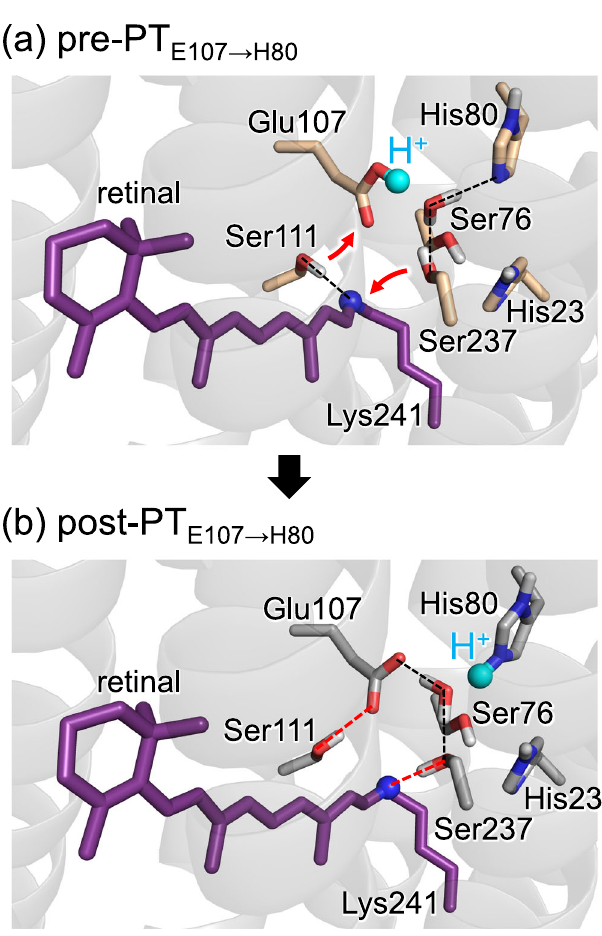
Fig. 4 Reorientations of serine residues owing to proton transfer from Glu107 to His80 in QM/MM calculations. a Pre-PT E107 → H80 conformation. b Post-PT E107 → H80 conformation. Dotted lines indicate H-bonds. Red curved arrows indicate the reorientations of serine residues. Red dotted lines indicate H-bond formations induced by proton transfer from Glu107 to